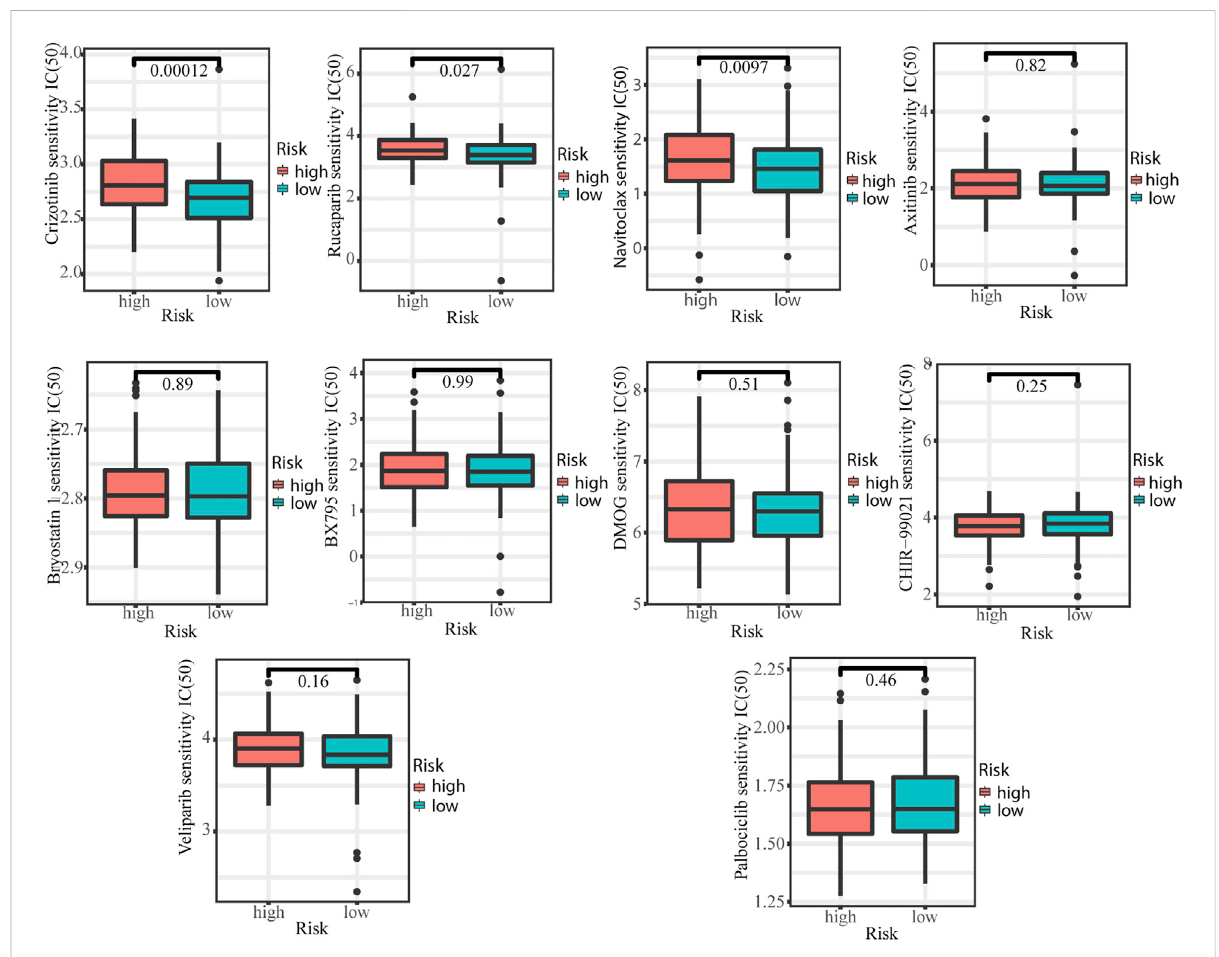
FIGURE 8 Comparison of IC50 of commonly targeting agents between low- and high-risk